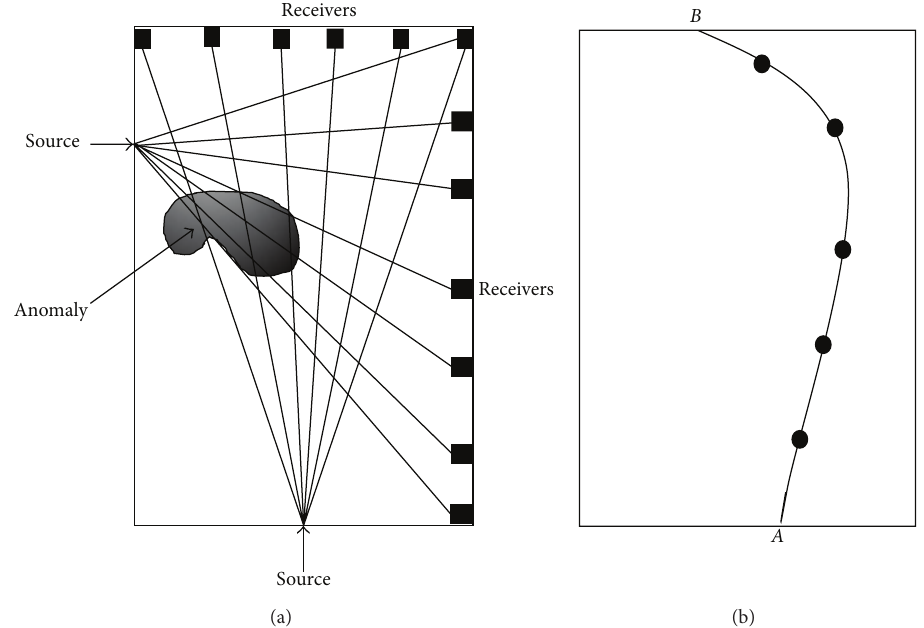
Figure 1: (a) Schematic illustration of anomaly projections with ray trace from source nodal to multiple receivers [1]; (b) an example of one-ray traces from point 𝐴 to point 𝐵 based on illustration